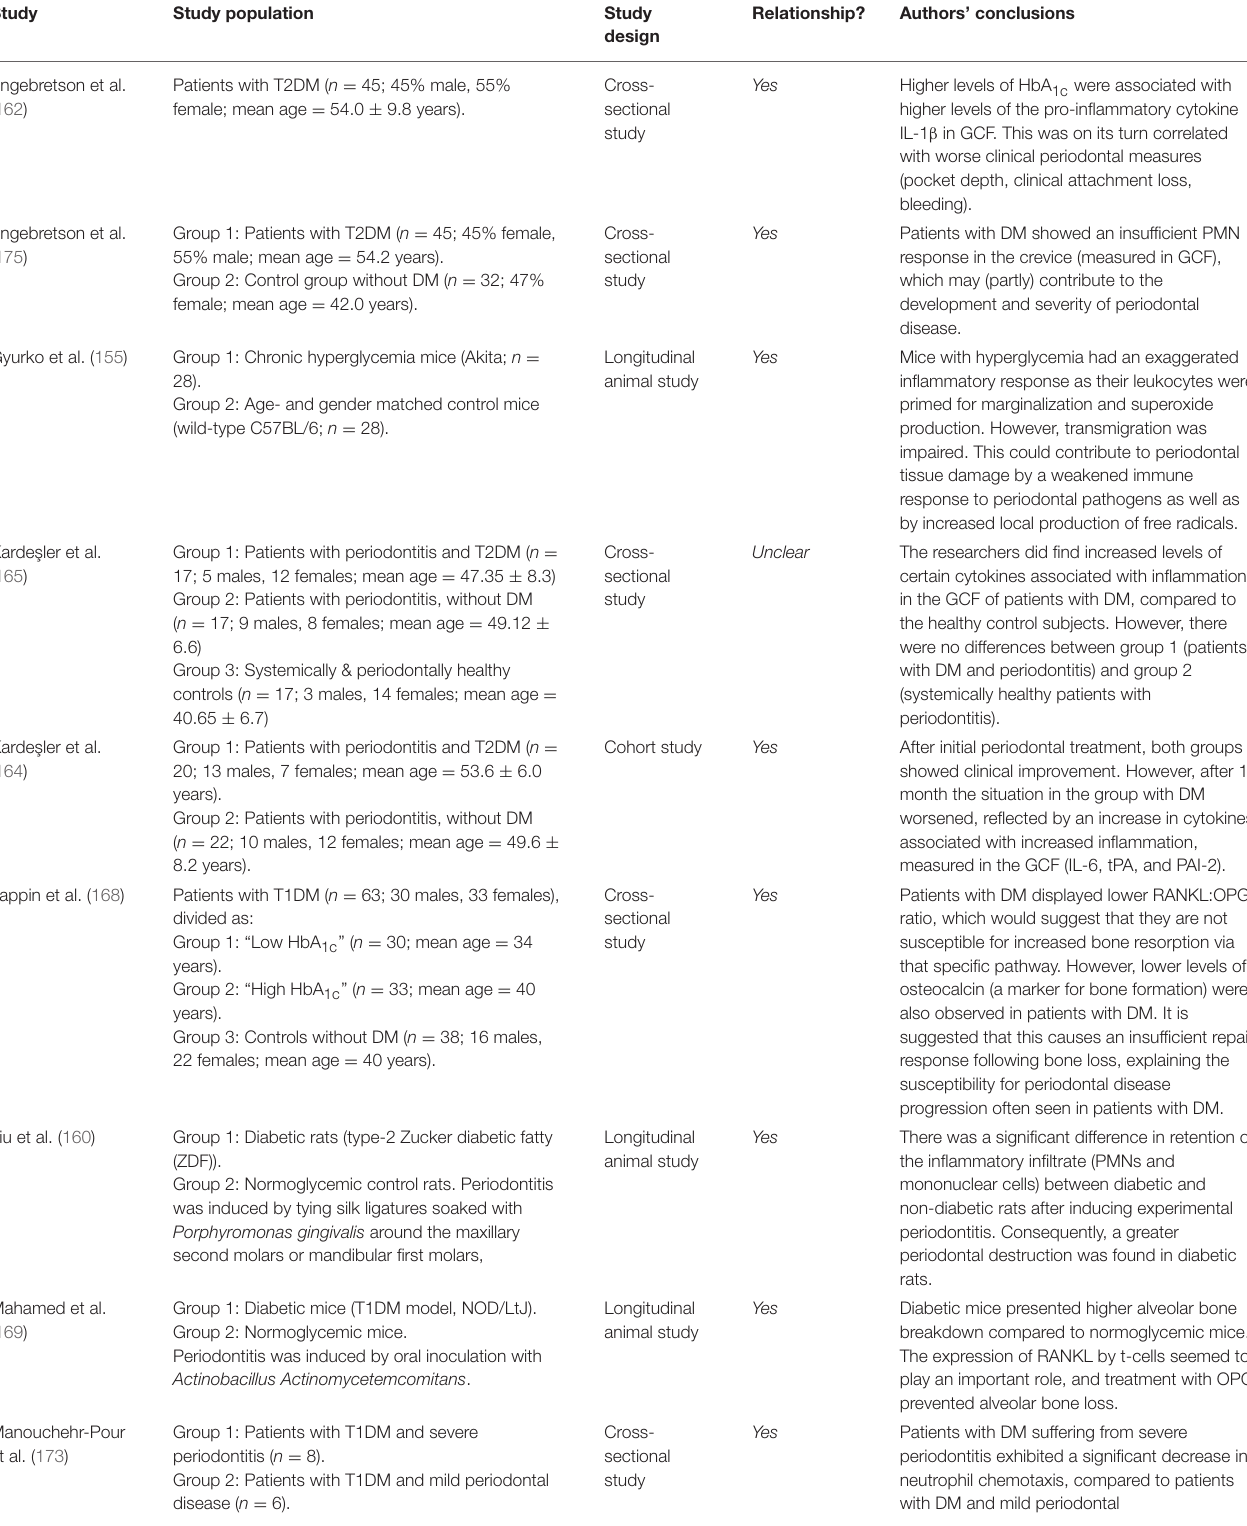
Yes Diabetic mice presented higher alveolar bone Longitudinal animal study breakdown compared to normoglycemic mice. The expression of RANKL by t-cells seemed to play an important role, and treatment with OPG prevented alveolar bone